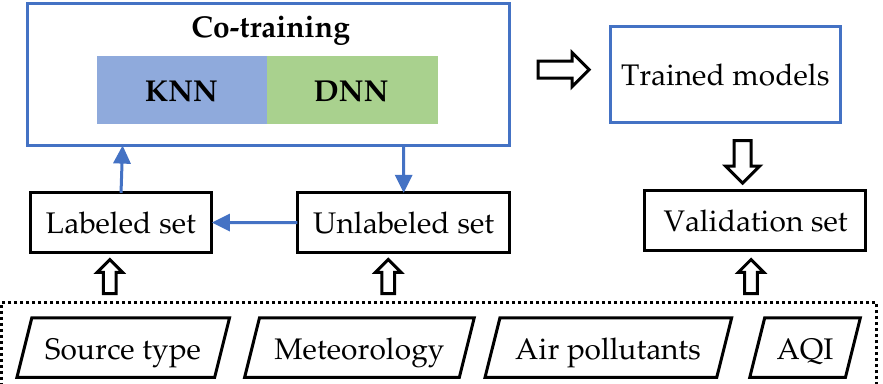
Figure 7. The overall framework of KNN-DNN for fine-grained analysis of air quality.